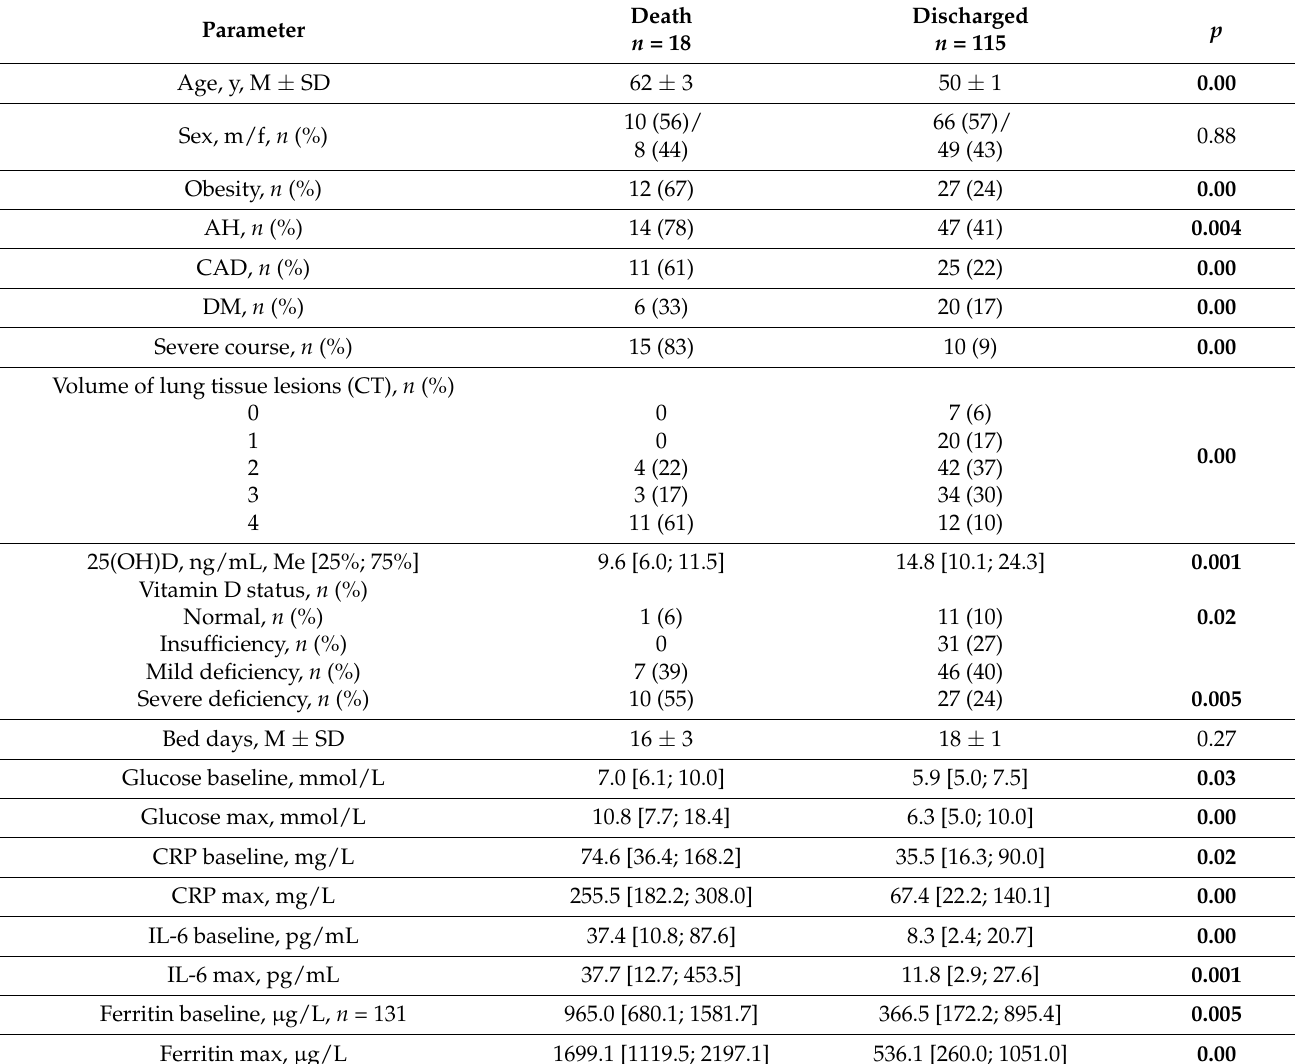
Table 3. COVID-19 patient characteristics in relation to disease